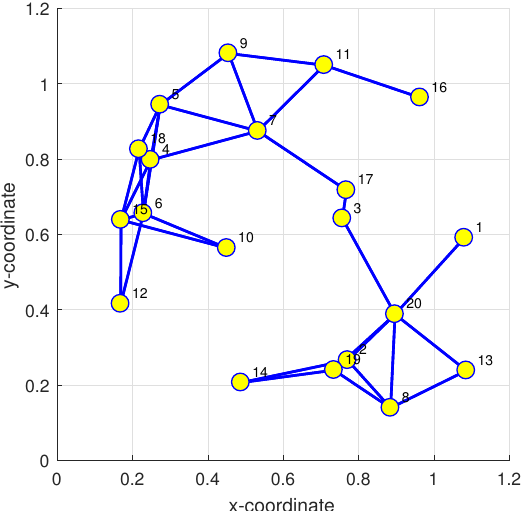
Figure 6. A strongly-connected topology of IWSN with N = 20